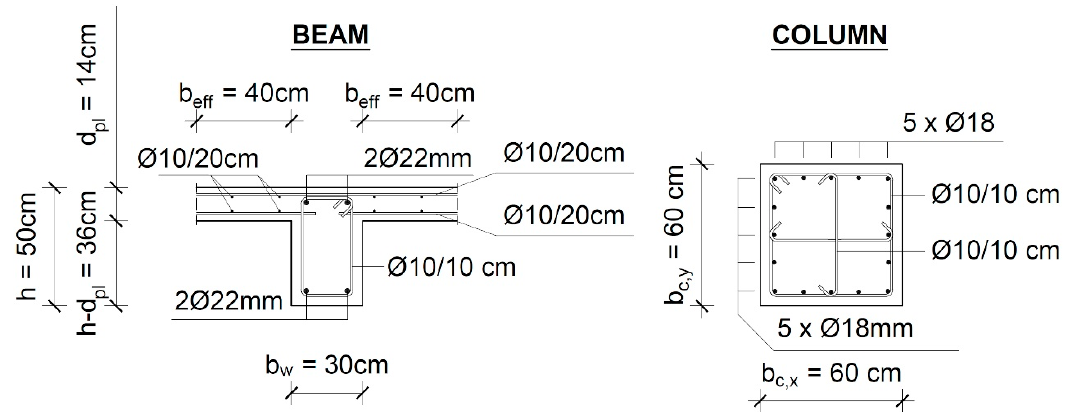
Figure 2. Geometric and reinforcement characteristics of the cross-section properties of the beams ( left ) and columns ( right ).